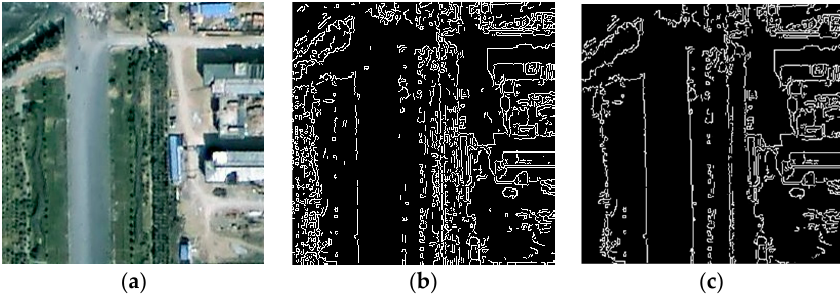
Figure 4. An example of adding the missing edge features for training sample processing: ( a ) The original image, ( b ) preliminary edge features extracted by the Canny operator, ( c ) edge features after adding the missing edges by manual operation.